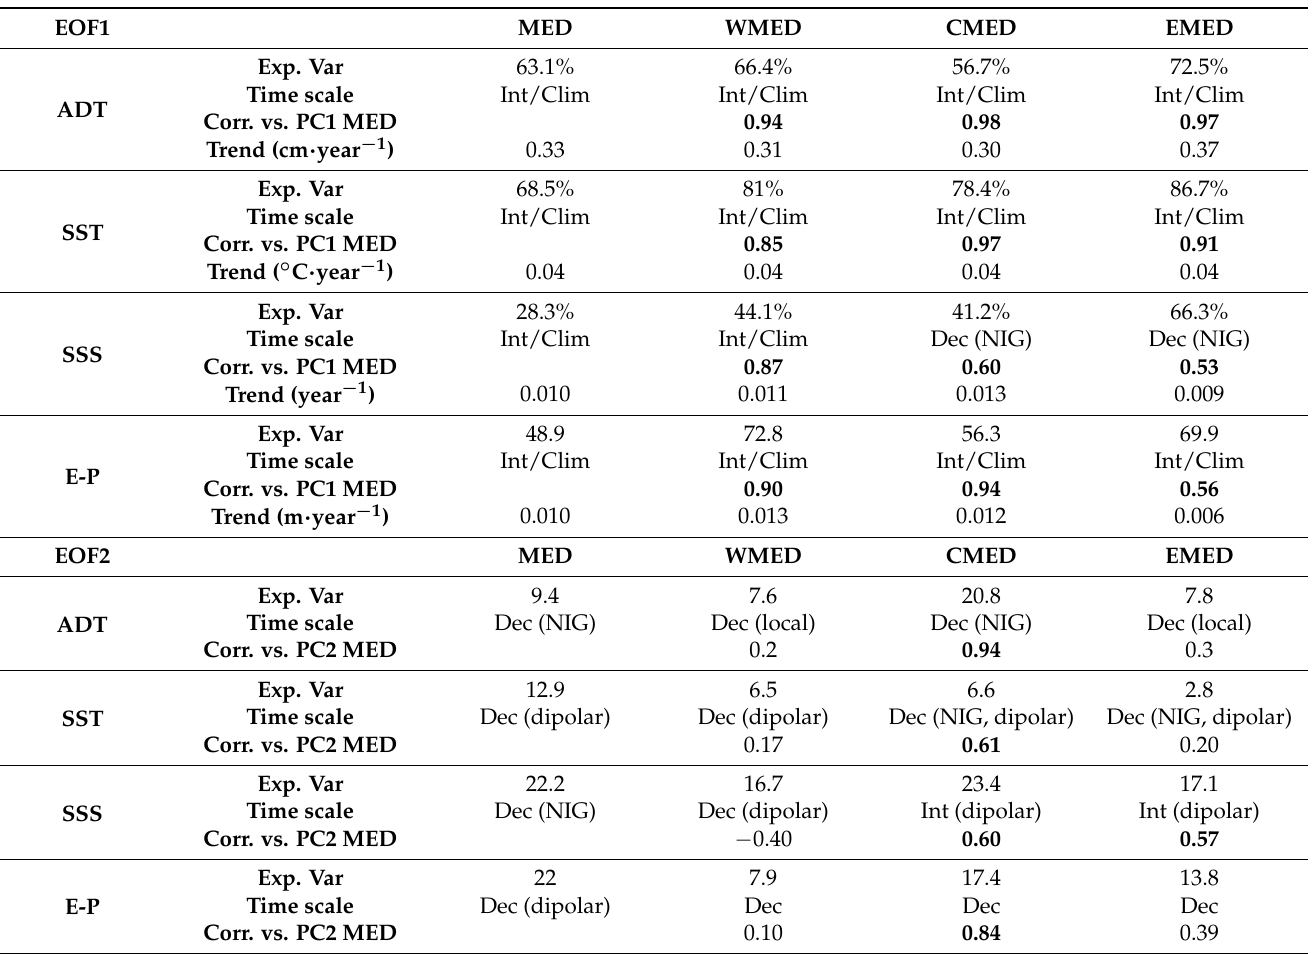
Table 1. Explained variance of the EOF1 and EOF2 modes in the MED and in its sub-basins (WMED, CMED, and EMED), time scale involved, and correlation coefficients ( p -value < 0–05; 95% confidence level) between the PCs of the MED and those of its sub-basins related to all the parameters considered. Correlation ≥ 0.5 are emphasized in bold in the table and described in the text. Time scales are indicated by Int (interannual), Dec (decadal), and Clim (climatic). The decadal variability linked to the NIG as well as that related to the local structures or to sub-basin dipolar spatial distribution are highlighted in brackets.